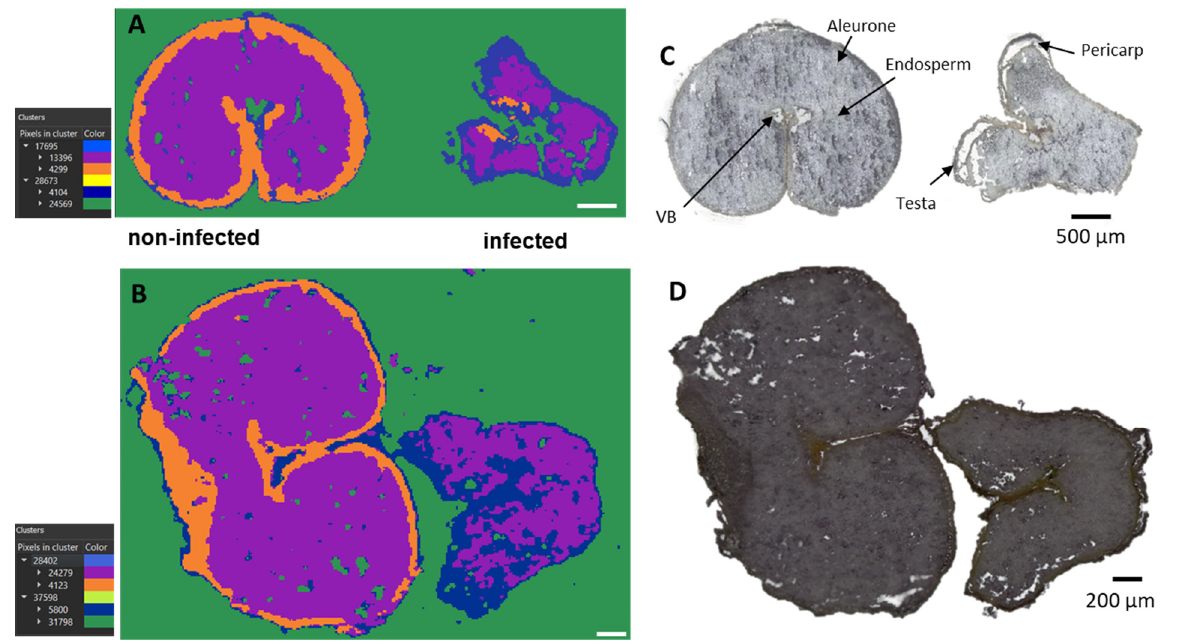
Figure 1. Bisecting k-means exploratory data analysis for AP-SMALDI imaging of durum ( A ) and common wheat ( B ) samples to visualize inter- and intra-sample comparison. ( C , D ) Optical images of ( C ) durum and ( D ) common wheat cross-sections. Segmentation clusters expanded to the third layer. Out-of-tissue (green) and in-tissue (blue, purple, and orange) clusters were identified. The hierarchy relations between clusters are shown in the legend.